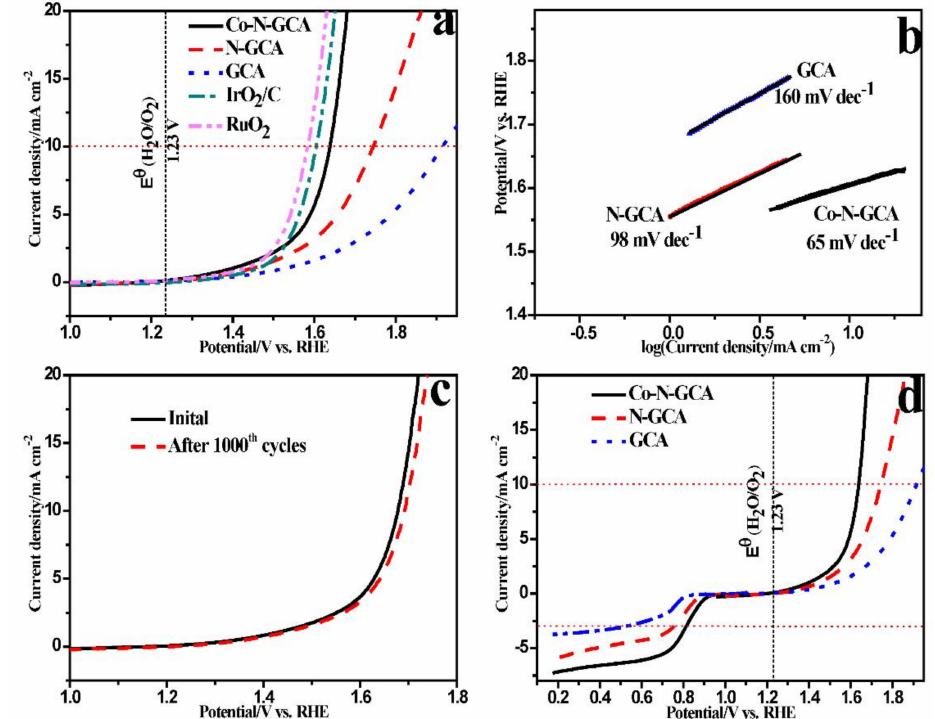
Figure 6. Oxygen evolution reaction (OER) LSV curves of Co-N-GCA, N-GCA, GCA, IrO 2 /C, and RuO 2 at 1600 rpm in O 2 -saturated 0.1 M KOH solution ( a ); OER Tafel plots of Co-N-GCA, N-GCA, and GCA ( b ); OER LSV plots of Co-N-GCA in the beginning and after 1000 cycles ( c ); and the overall LSV curves of Co-N-GCA, N-GCA, and GCA at 1600 rpm in O 2 -saturated 0.1 M KOH solution ( d